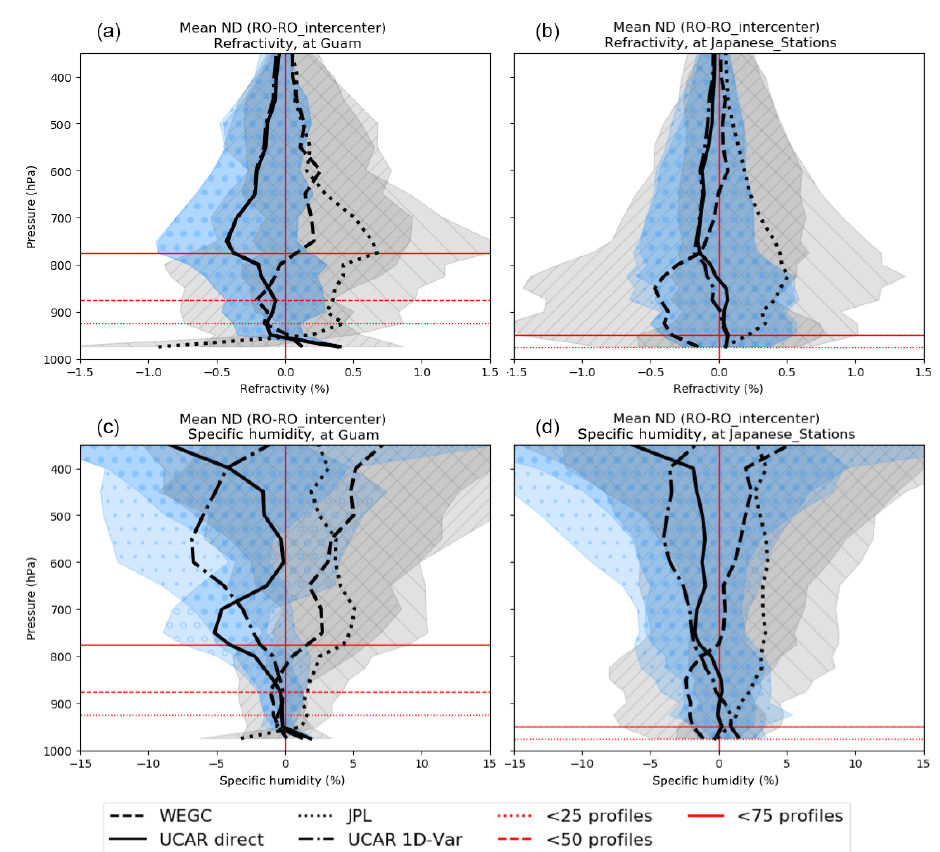
Figure 10. Deviations for four RO retrievals from the inter-center mean for refractivity (a, b) and specific humidity (c, d) at Guam (a, c) and the Japanese stations (b, d) . The mean (and standard deviation) of each data set is shown by line style (and as shaded and hatched area): UCAR direct: black solid (and o o o, blue); UCAR 1D-Var: black dash-dotted (and · · · , blue); WEGC 1D-Var: black dashed (and ///, gray); JPL direct: black dotted (and (cid:114) (cid:114) (cid:114) , gray). Red horizontal lines indicate the number of profile pairs at that pressure